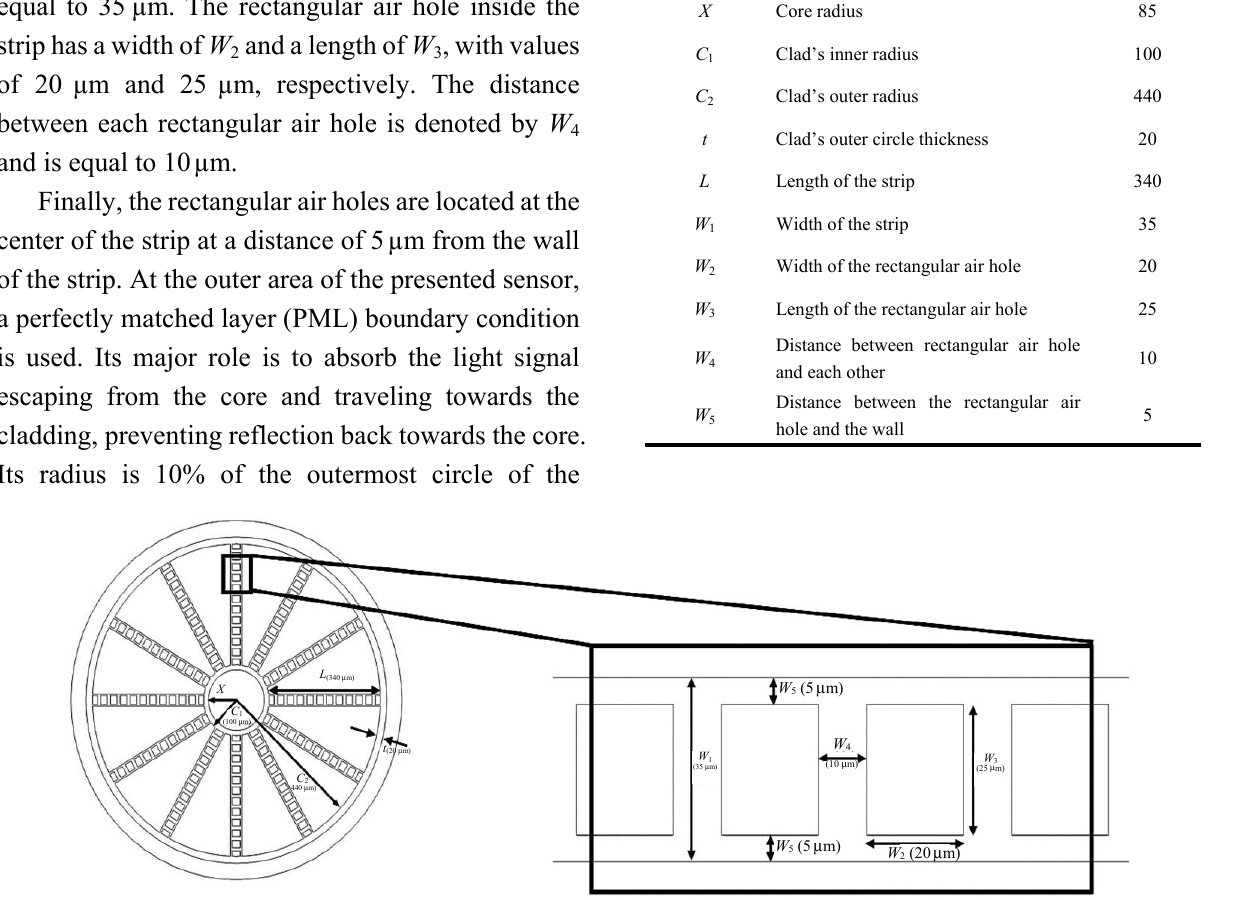
Fig. 2 Geometrical parameters of the proposed